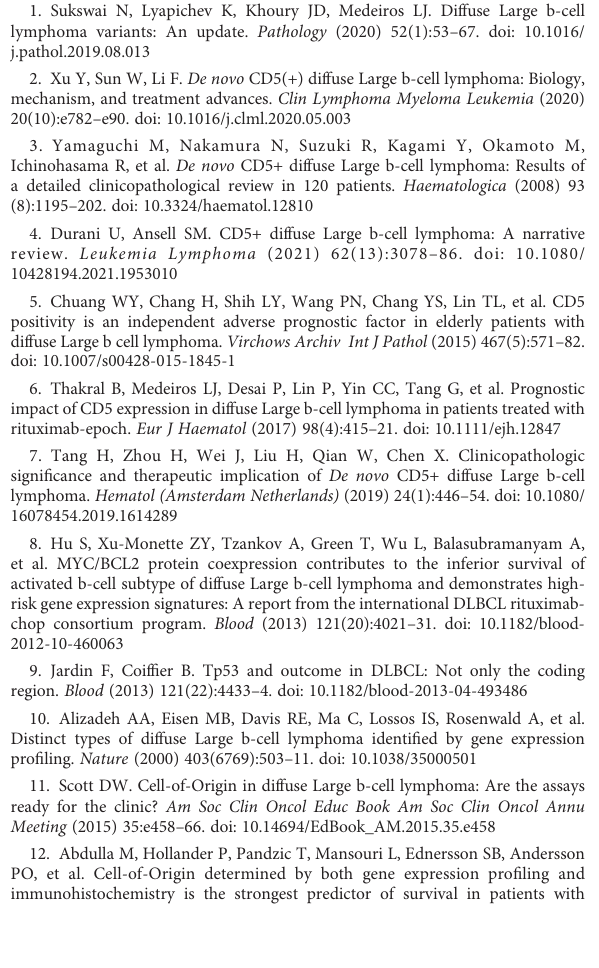
SUPPLEMENTARY FIGURE 4 mRNA expression ofnine genes showed asigni fi cantcorrelation withPFS, including (A) LIMD1 , (B) CYB5R2 , (C) RAB7L1 , (D) MME , (E) SERPINA9 , (F) ABS13 , (G) MAML3 , (H) MYBL1 , and (I) S1PR2 .